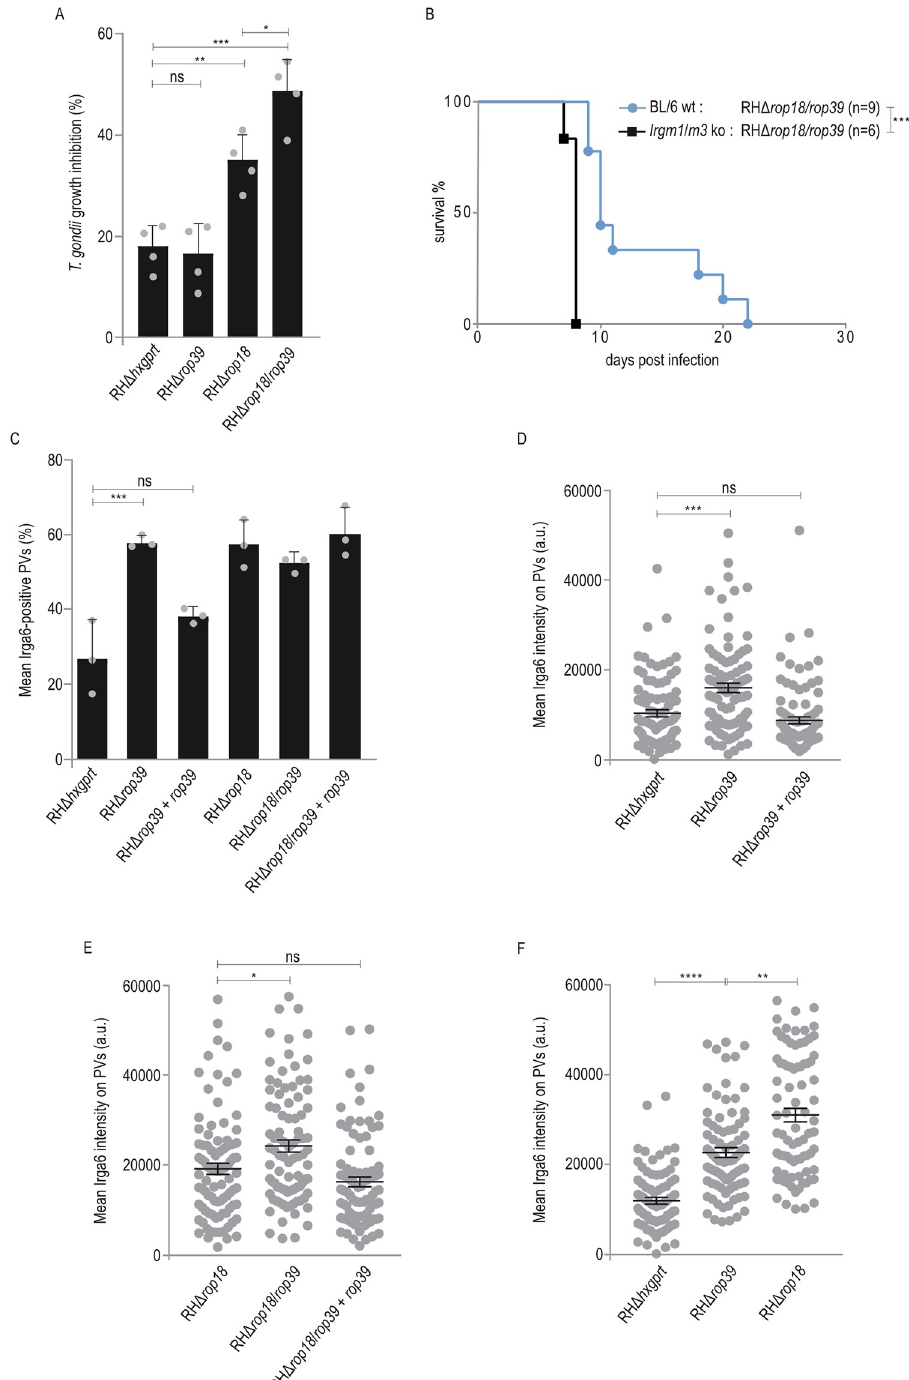
Fig 5. ROP39 is important to inactivate the IFN γ -inducible IRG response. A, Plaque assay. Mouse embryonic fibroblasts grown in 6 well-plates in presence or absence of IFN γ (100 U/ml) for 24 h were infected with 200 freshly prepared T . gondii tachyzoites. At 7 d post infection, cell monolayers were stained with crystal violet. Error bars indicate the mean and standard error of the mean (SEM) of four independent experiments. One-way analysis of variance (ANOVA) followed by Tukey´s multiple comparison was used to test differences between groups; ��� p < 0.001; �� p < 0.01; � p < 0.05; ns not significant. B, Survival of C57BL/6 Irgm1 / Irgm3 ko or wt mice that were intraperitoneally infected with 1,000 freshly prepared tachyzoites of T . gondii RH Δ rop18 / rop39 . A log-rank